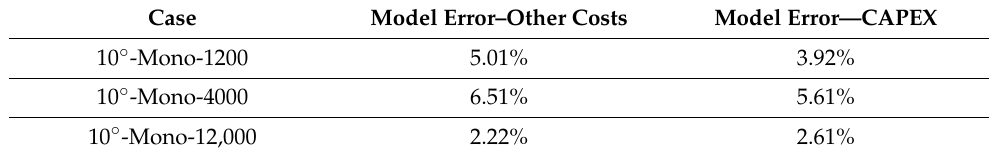
Table 10. Model error for the three base cases in the calculation of normalized costs.